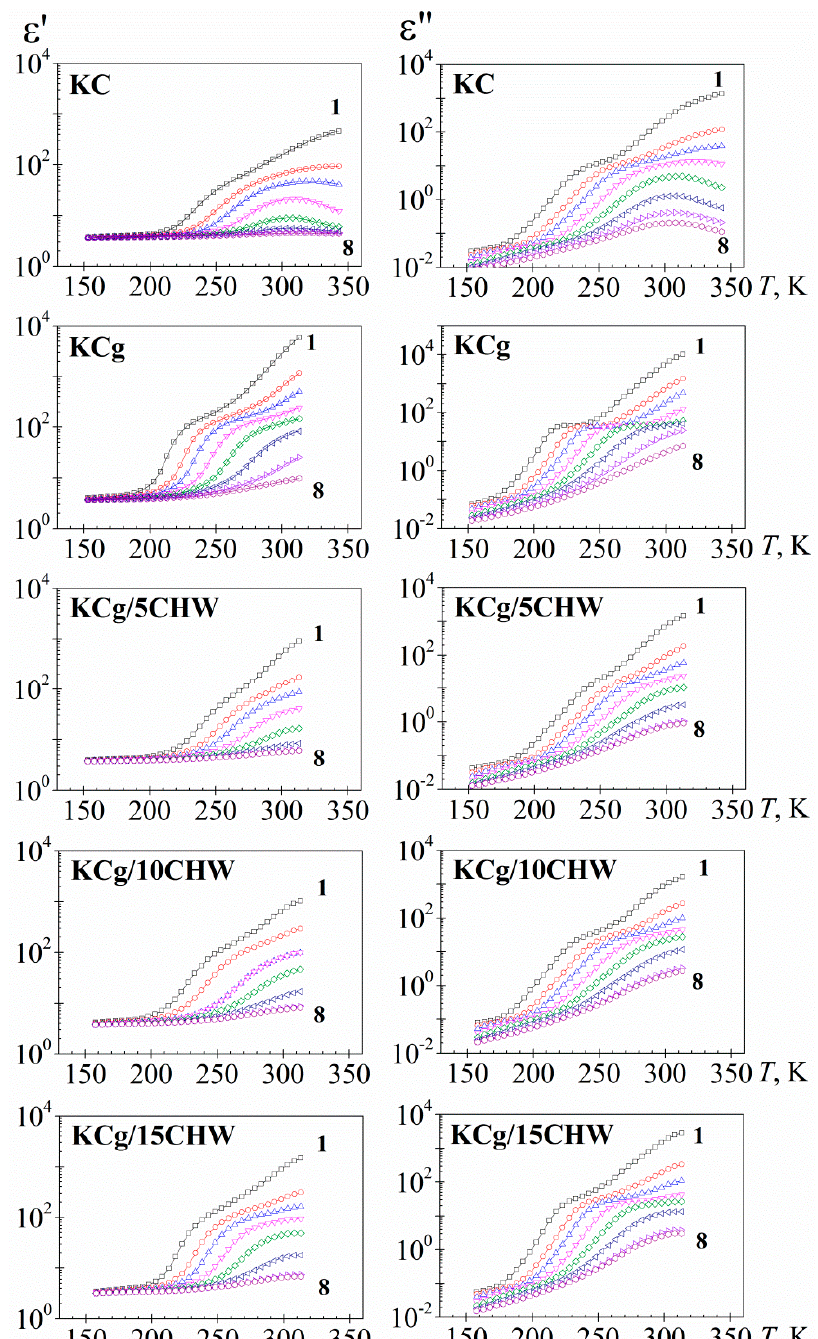
Figure 1. Temperature dependence of the dielectric permittivity, ε ′ (left) and the dielectric loss, ε ″ , (right) for the samples studied, at several frequencies in Hz ( 1 : 4.9 10 − 2 , 2 : 1.2 10 0 , 3 : 8.7 ⋅ 10 0 , 4 : 9.5 10 1 , 5 : 1.0 10 2 , 6 : 1.1 10 4 , 7 : 1.2 10 5 , 8 : 9.1 10 5 ).